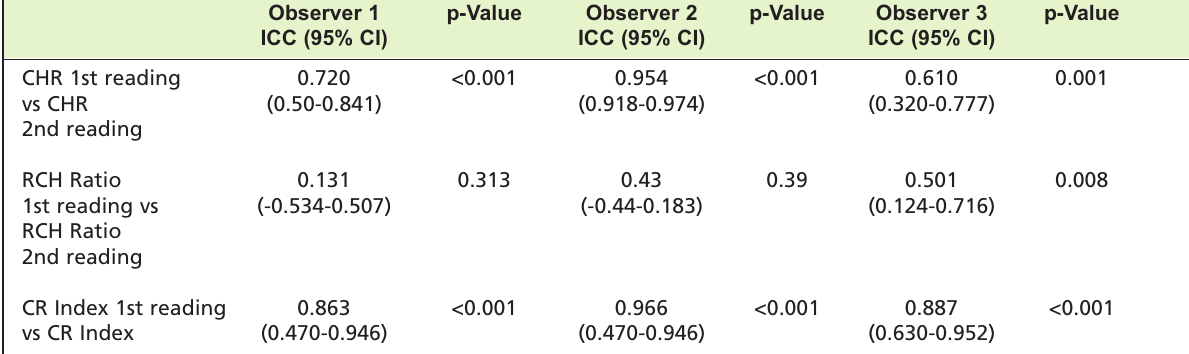
Comparison of the first and second readings of individual observers Table II: